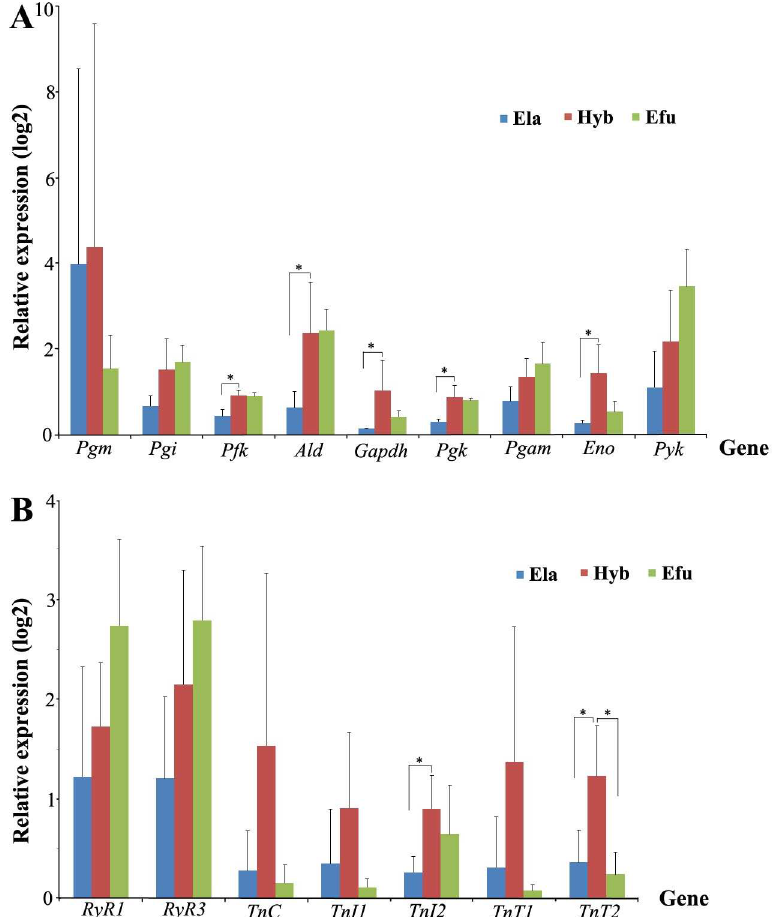
Fig 4. qRT-PCR validation of candidate genes. Nine glycolytic genes (A), RyR and Tn (B) were picked out as representatives of differences betweenthe Hyb and its parents. β -actinwas used as the internalcontrol, and each value represents an averageof three separate biologicalreplicates. The error bars representthe standarddeviation.Asterisk ( * ) was marked if there was significantdifference betweenthe two samples, as assessedby a t-test ( P <